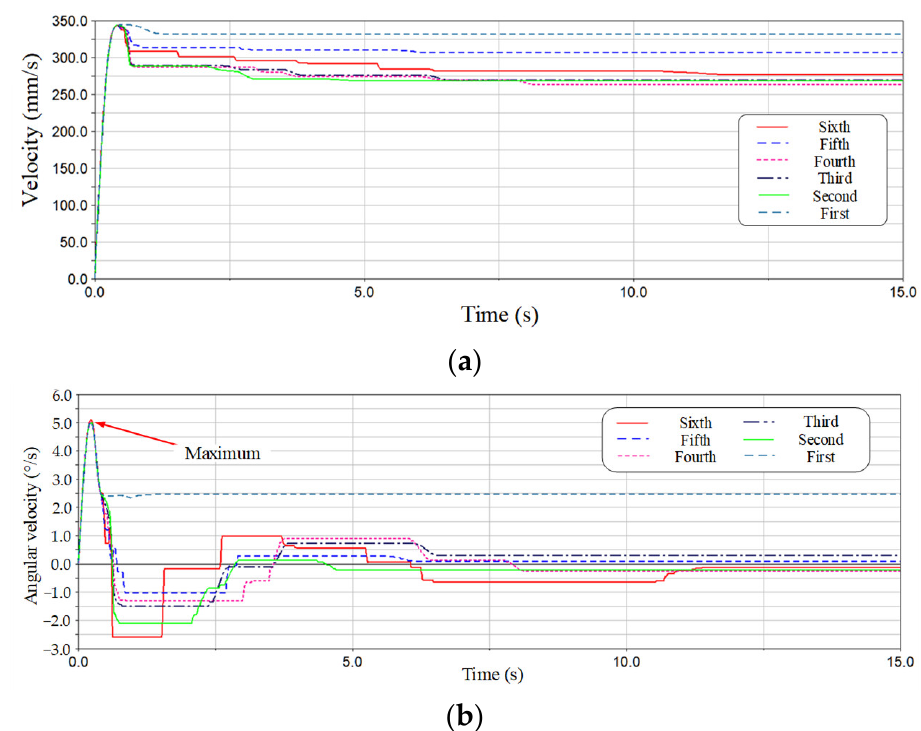
Figure 15. Comparison of the separation characteristics of six satellites: ( a ) Velocity versus time; ( b ) Angular velocity versus time.